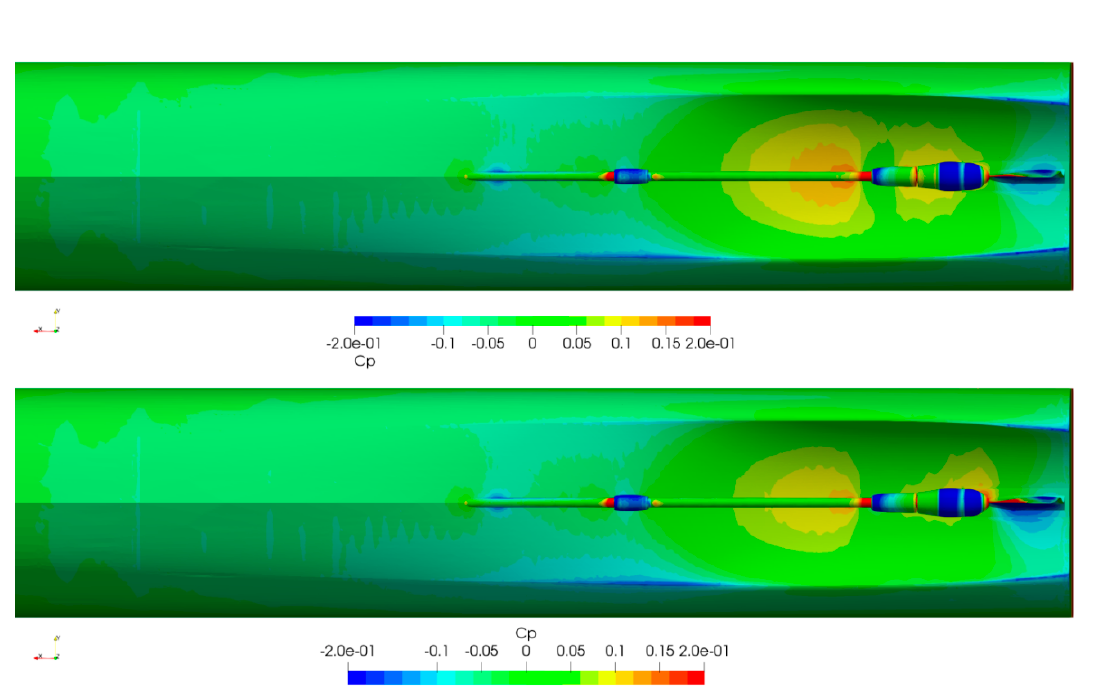
Figure 4. Comparison of computed pressure field in the portside demihull’s stern tunnel region; top, without propeller action at 23 knots; and bottom, with propeller action at 23 knots.